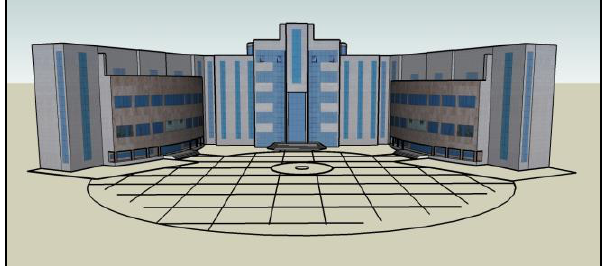
Figure 12. Rectorate Building of Karabuk University, Turkey